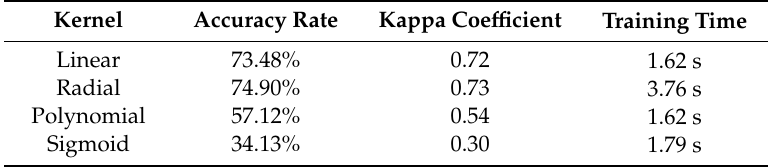
Table 4. Accuracy Results for di ff erent SVM